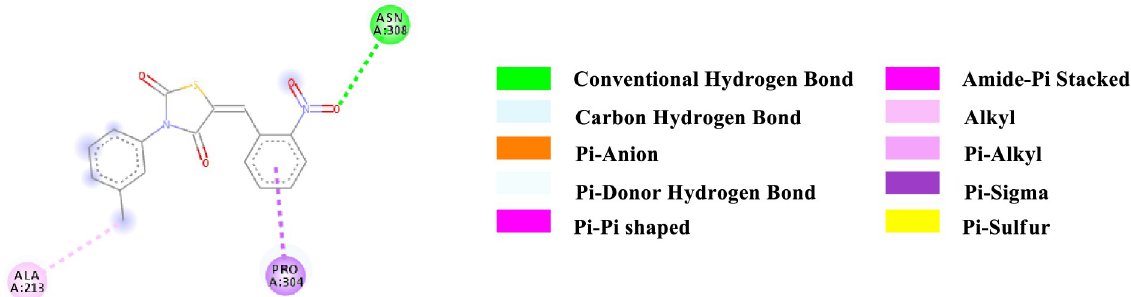
Fig 7. 2D-representation of the non-covalent interactions of 7c with receptor (3gbk) after flexible docking.